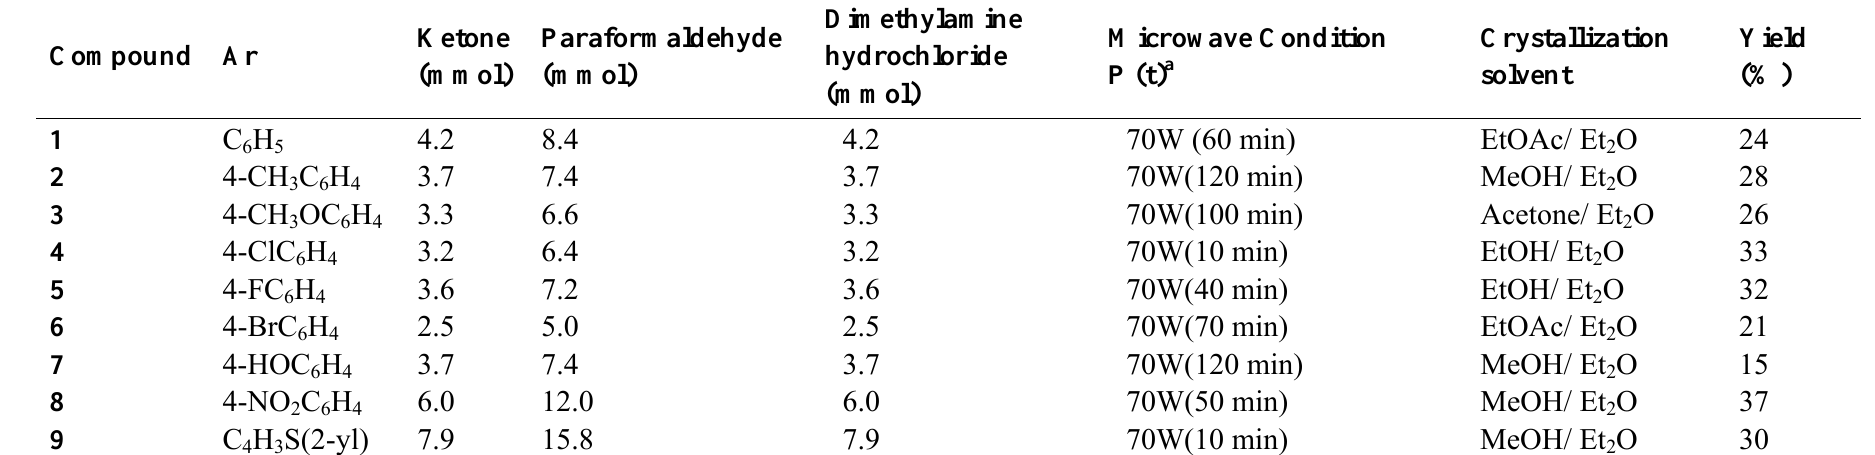
Table 2. Physical data of the reactions by microwave irradiation